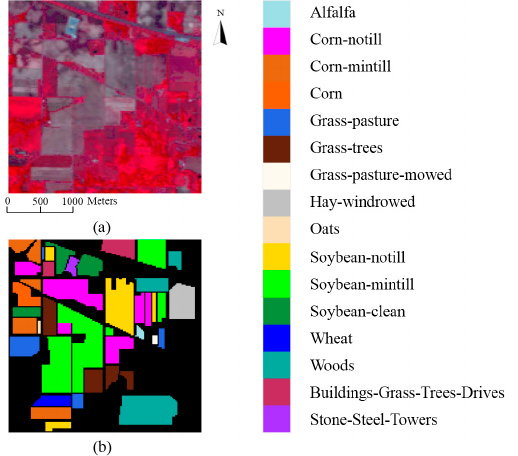
Figure 6. ( a ) False-color composite. ( b ) Ground truth; black area denotes unlabeled pixels.